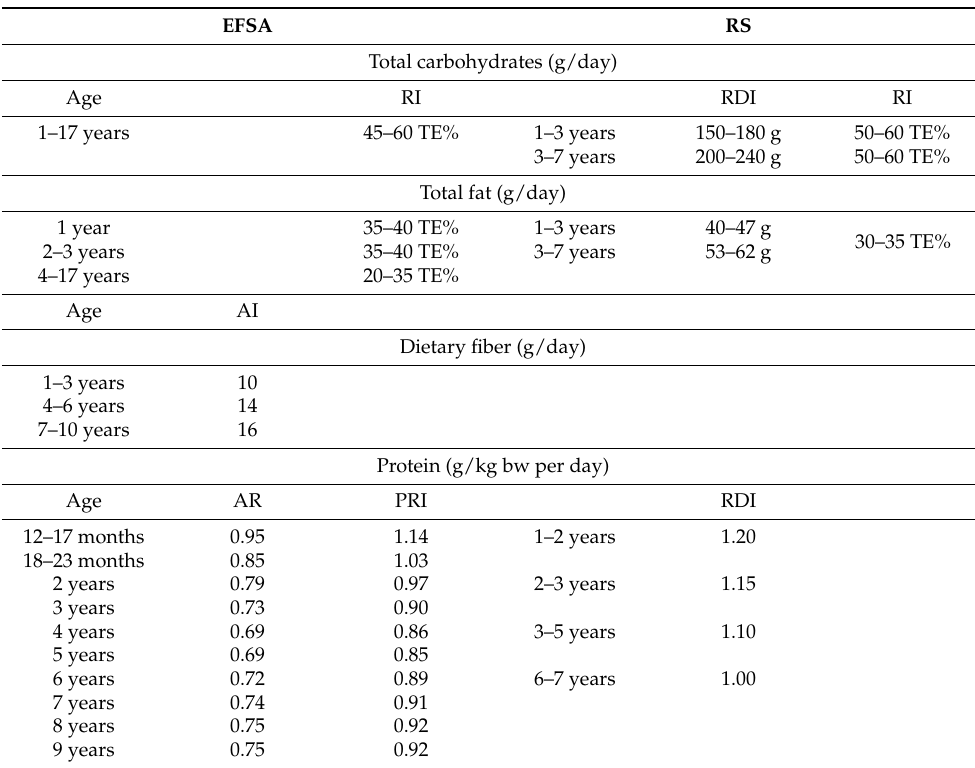
Table 1. Comparative overview of EFSA and Serbian daily requirements for carbohydrates, protein, and fat for 1–9-year-old